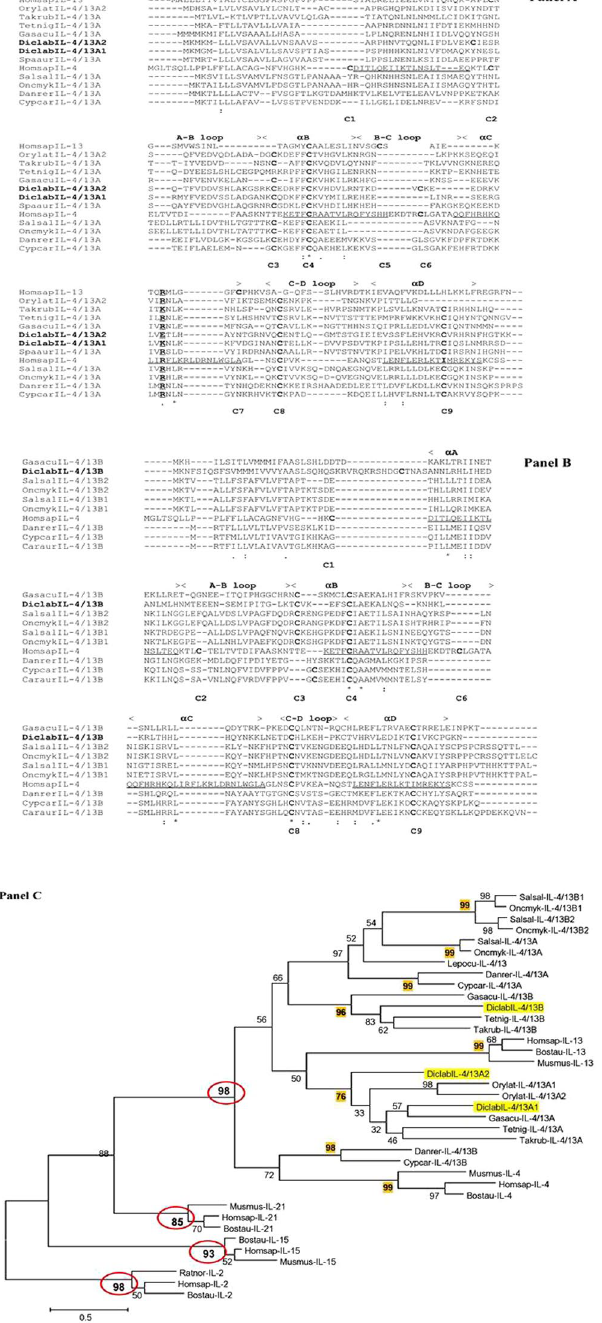
Figure 2. Panel A and Panel B. Amino acid sequence alignment of the predicted sea bass IL-4/13 isoforms with selected IL-4/13 molecules . The conserved amino acids are indicated with an “ ” below the sequences, while * “.” and “:” show amino acids with conserved physical and/or chemical properties. The position of the nine cysteine residues found in the different sequences is highlighted below the alignment and shown in bold along the sequences. The four α -helices and loop regions known for human IL-4 are shown above the alignment and the amino acids involved in the α -helices underlined in the human IL-4 sequence. Panel C. Phylogenetic tree analysis of fish IL-4/13 molecules with mammalian IL-4/IL-13 molecules and other closely related γ -chain cytokines IL-2, IL-15 and IL-21 . The phylogenetic tree was constructed using amino acid multiple alignments and the neighbour-joining method within the MEGA7 program. The percentage of replicate trees in which the associated taxa clustered together in the bootstrap test (10,000 replicates) was shown next to the branches. Lepisosteus oculatus (spotted gar) IL-4/13 was predicted from chromosome LG6. The bootstrapping values that support lineage-specific groupings are highlighted with a yellow